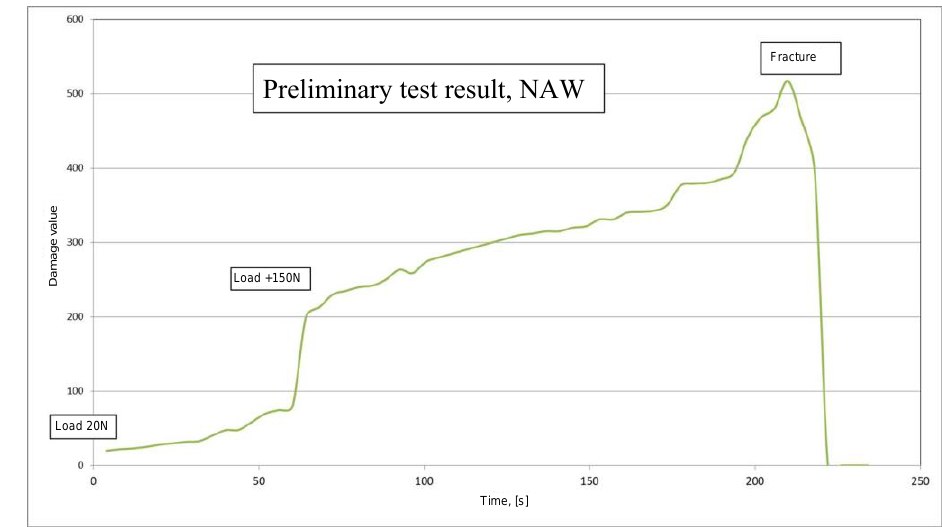
Fig. 4 Results from the test setup with the constant